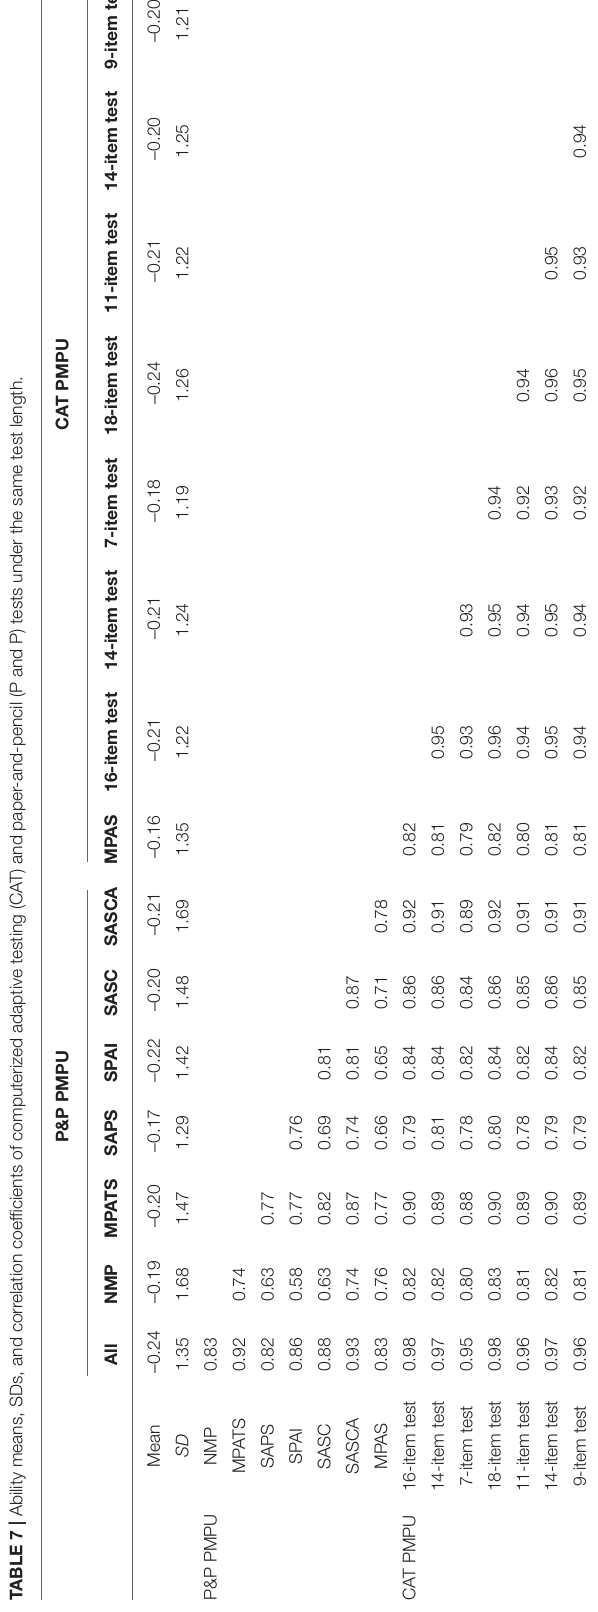
TABLE 5 | Measurement error of two test methods under same test length.